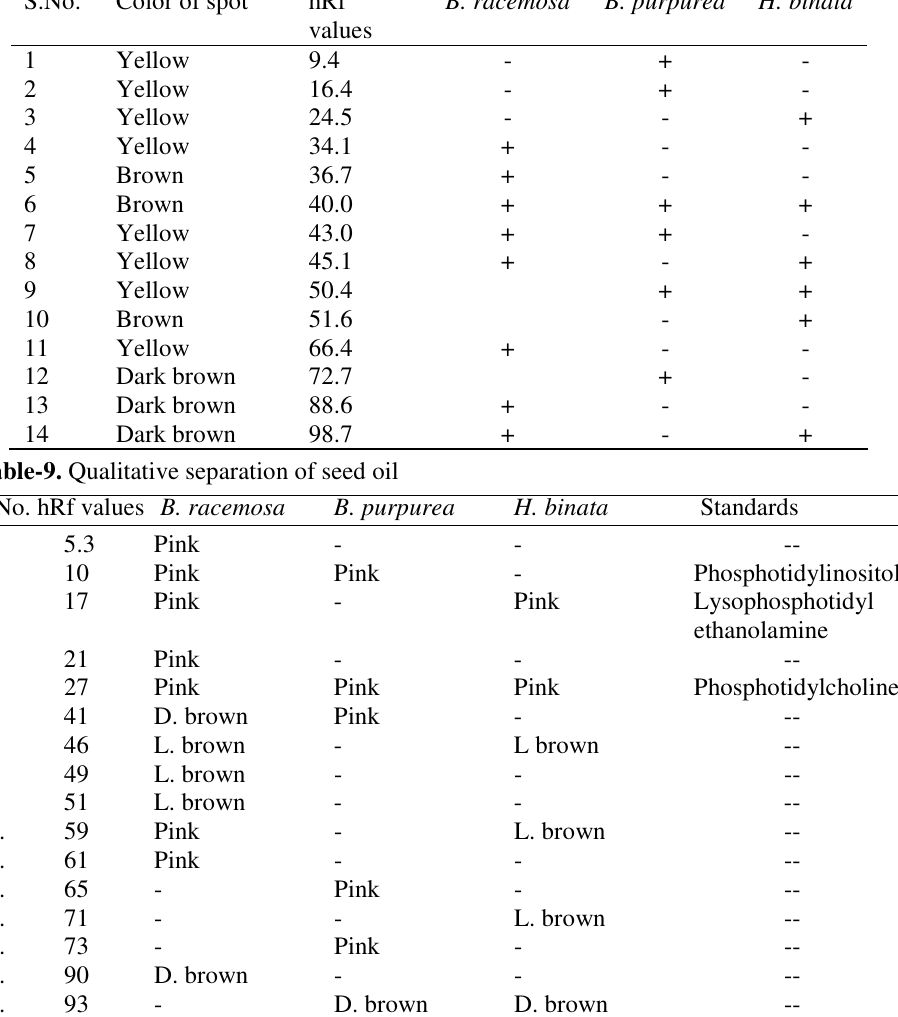
Table-8 . Qualitative separation of saponins S.No.